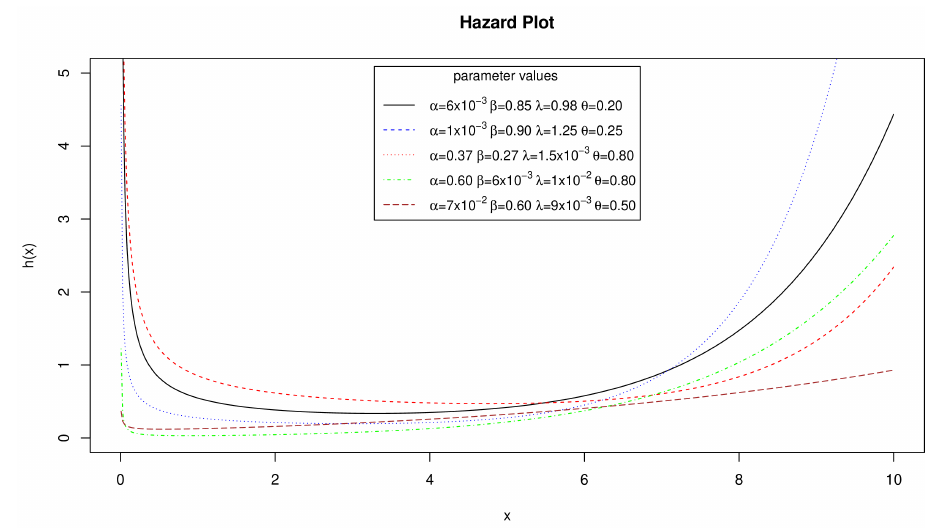
Figure 2. Hazard Rate for some parameter values derived of